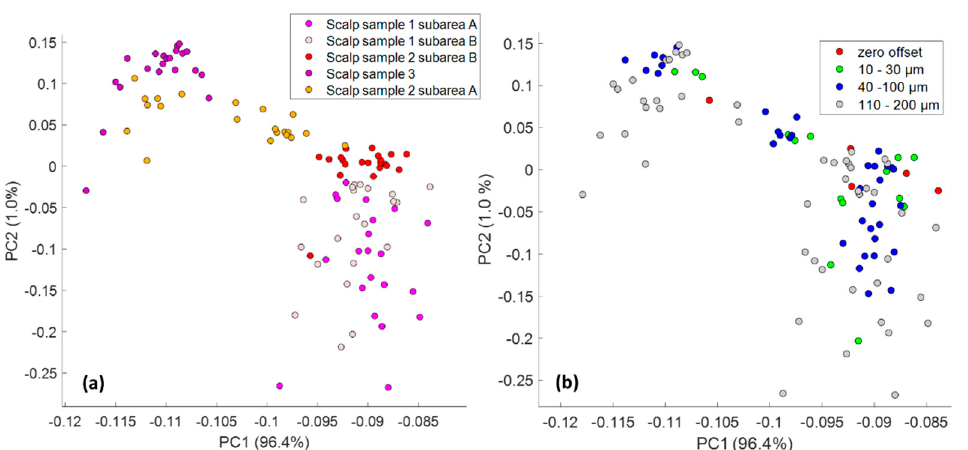
Figure 6. PCA scatter plots for Raman spectra collected from scalp skin of ( a ) different sample areas and donors and ( b ) different offsets.